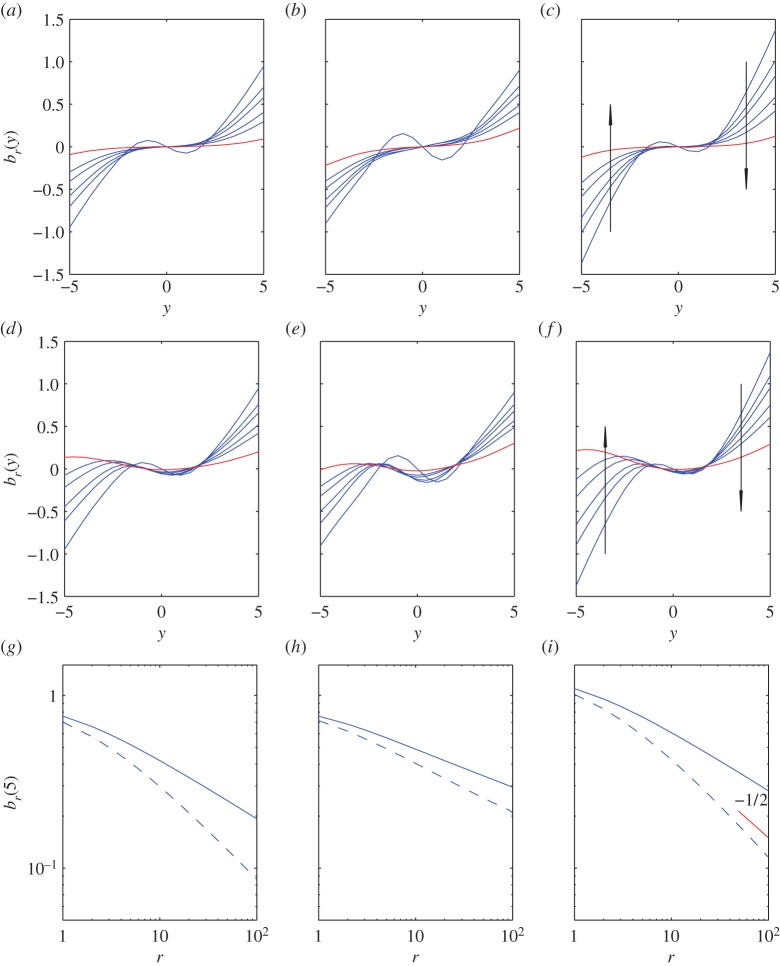
Panels (a–c) show br(y) versus y for r=0,1,2,5,10,90 (arrows in (c) and (f) show the direction of increasing r) for the three models: (a) (1.5), (b) (1.6), (c) (1.7), with Y0=0. (d–f) are the same, but now with initial condition Y0=−2. Panels (g–i) show the variation of br(5) versus r for Y0=0 (dashed) and Y0=−2 (solid). Panels are for (g) (1.5), (h) (1.6), (i) (1.7) and the slope −12 is shown in panel (i) for reference.